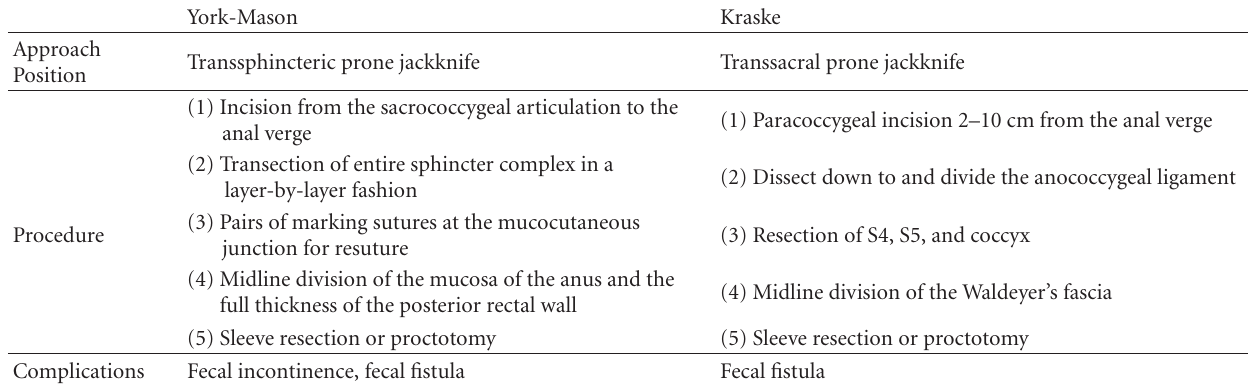
Table 1: Posterior approaches to